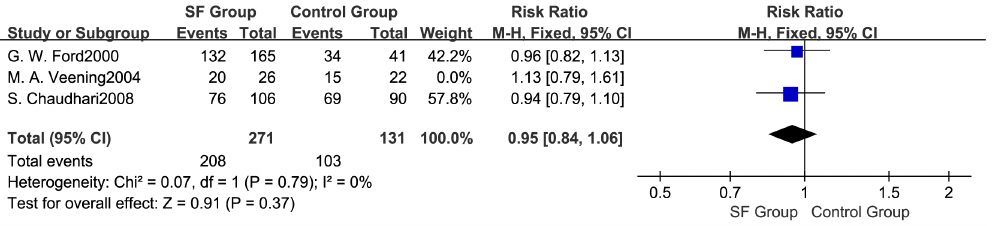
Figure 4. Sensitivity analysis for the number of pubertal children.